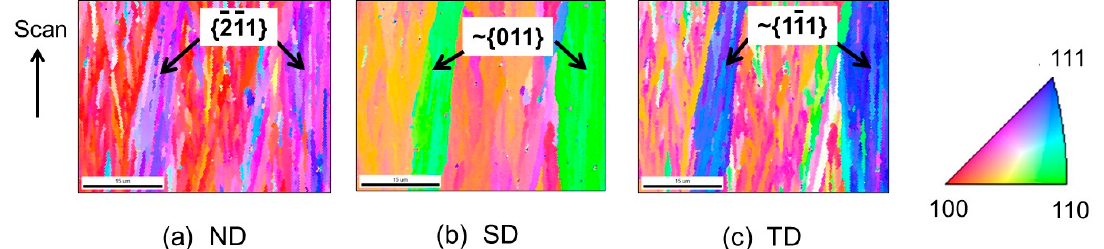
Figure 13. IPF maps of the crystallized film at a high effective laser power; ( a ) normal direction, ( b ) scan direction, and ( c ) transverse direction. The SiO 2 cap thickness was 183 nm, and the power was 2.6 W. The scan velocity was 15 mm/s. After Sasaki et al. [53].